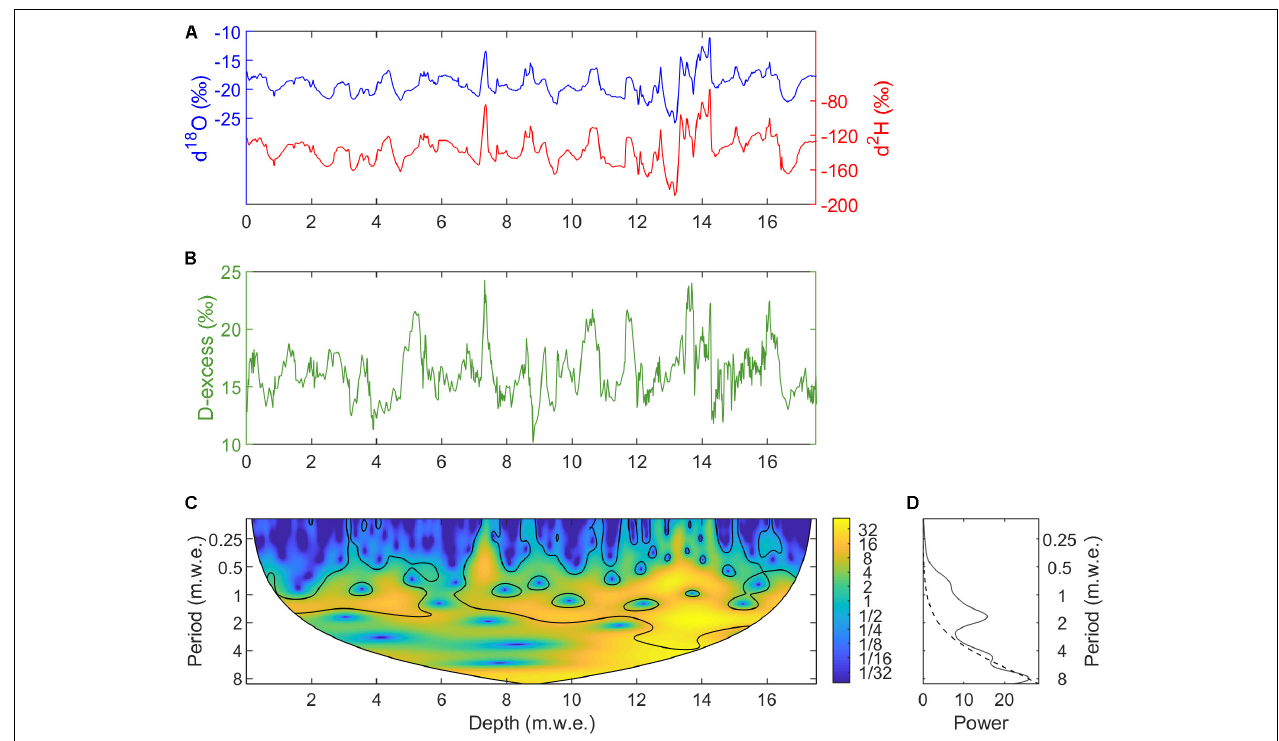
FIGURE 9 | Stable isotope profiles for the topmost 20 m of the Guanaco Glacier ice core. (A) δ 18 O and δ 2 H; (B) Deuterium excess; (C) Wavelet power spectrum of the δ 18 O series. Black contours delineate the 95% significance level against a red-noise (AR1) model with lag1 correlation r = 0.9; (D) mean wavelet power spectrum; stippled line shows the 95% significance level.